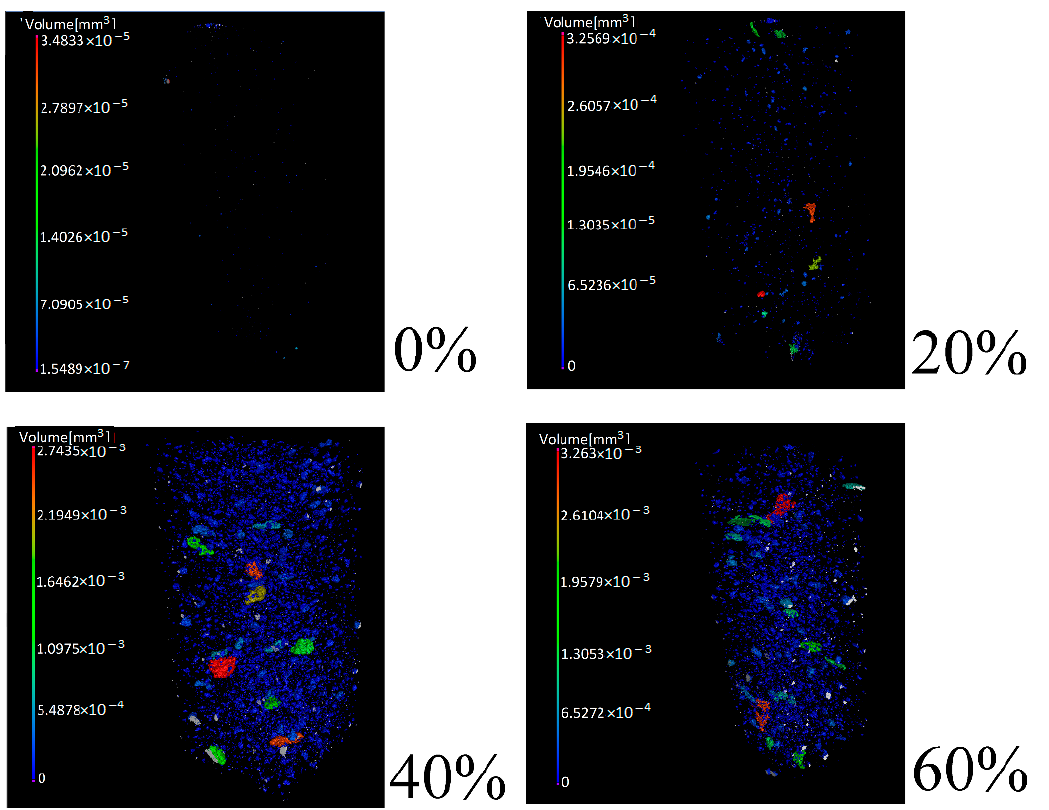
Figure 10. HA particles in SA hydrogels under differing integrations of HA (0%, 20%, 40%, and 60%).